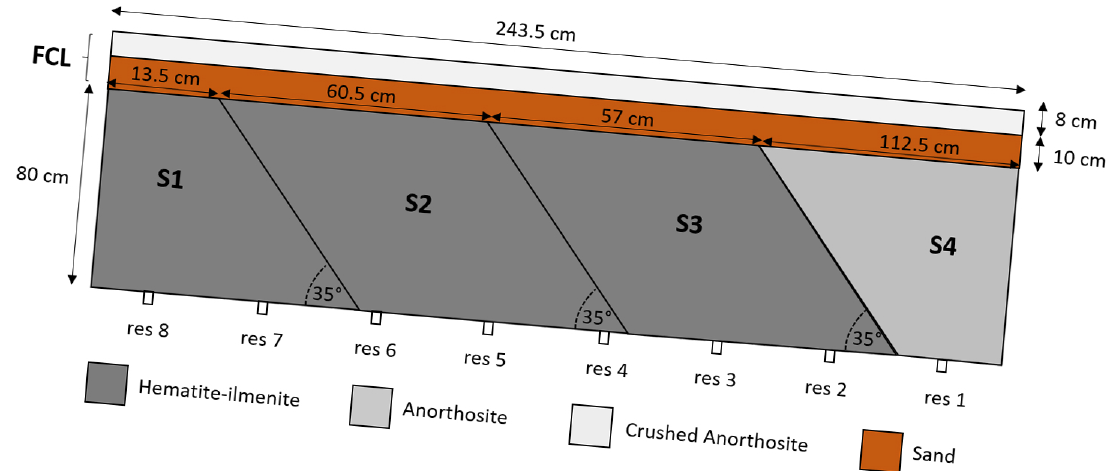
Figure 1. Schematic of the laboratory experiment with a flow control layer (FCL) rotated at 5 ◦ , adapted from Poaty